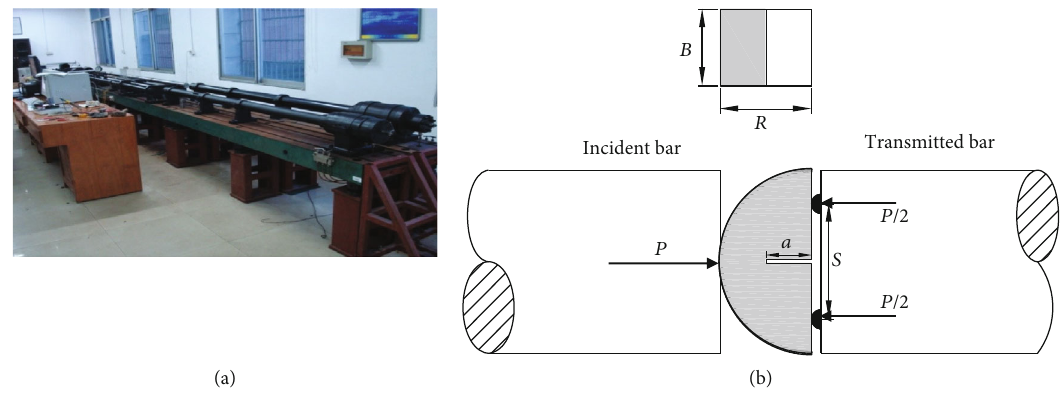
Figure 3: (a) SHPB system for rock dynamic fracture testing. (b) Schematics of the semicircular bend (SCB) specimen in the split Hopkinson pressure bar (SHPB)